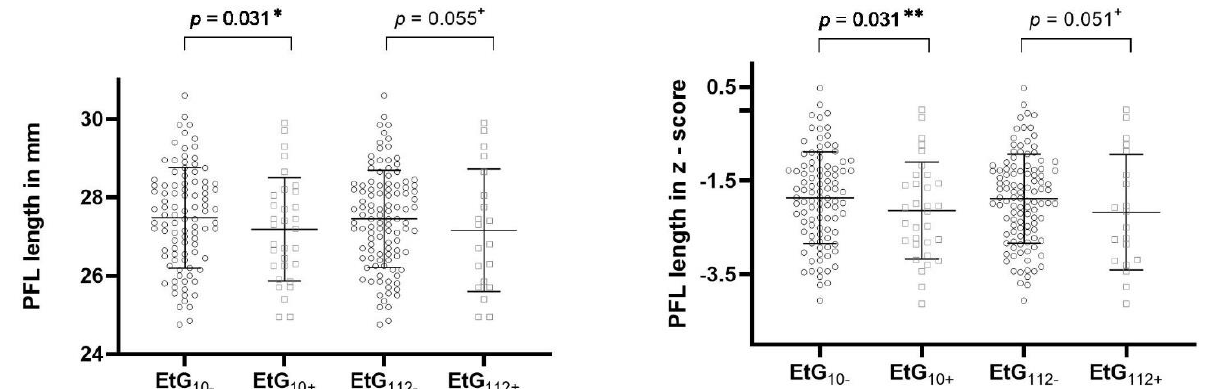
Figure 2. PFL length in millimeters and Z-score for EtG 10 ng/g (EtG10+ n = 32) and 112 ng/g (EtG112+ n = 20) cut-off values. Higher PFL value = longer eyes. Univariate ANCOVA results: + p < 0.10, * p < 0.05, and ** p < 0.01.